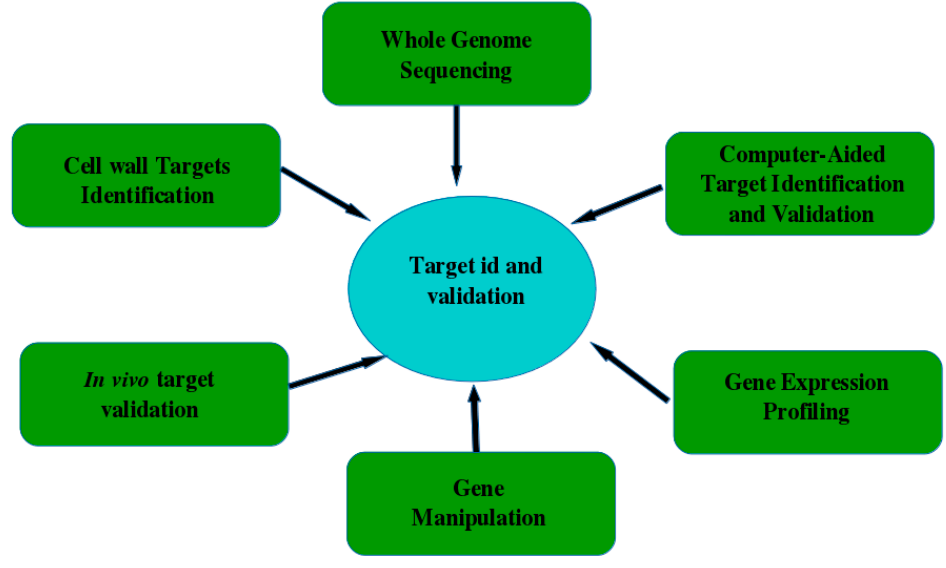
Figure 4. Schematic representation of some examples for target identification and validation.